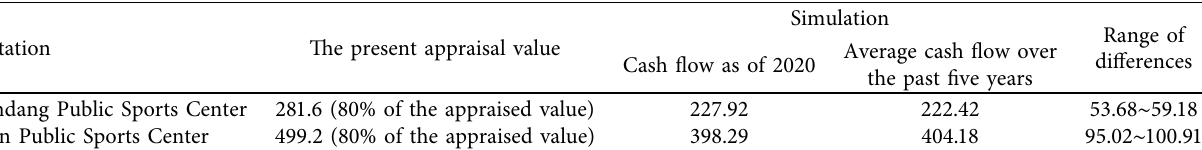
Table 4: Summary simulation of the sale price of the public sports centers in Bundang and Ilsan (unit: KRW 100 million). Sortation The present value Bundang Table 5: Comparison of the current appraised value and the simulation result of the sale price (unit: KRW 100 million). Sortation The present appraisal value